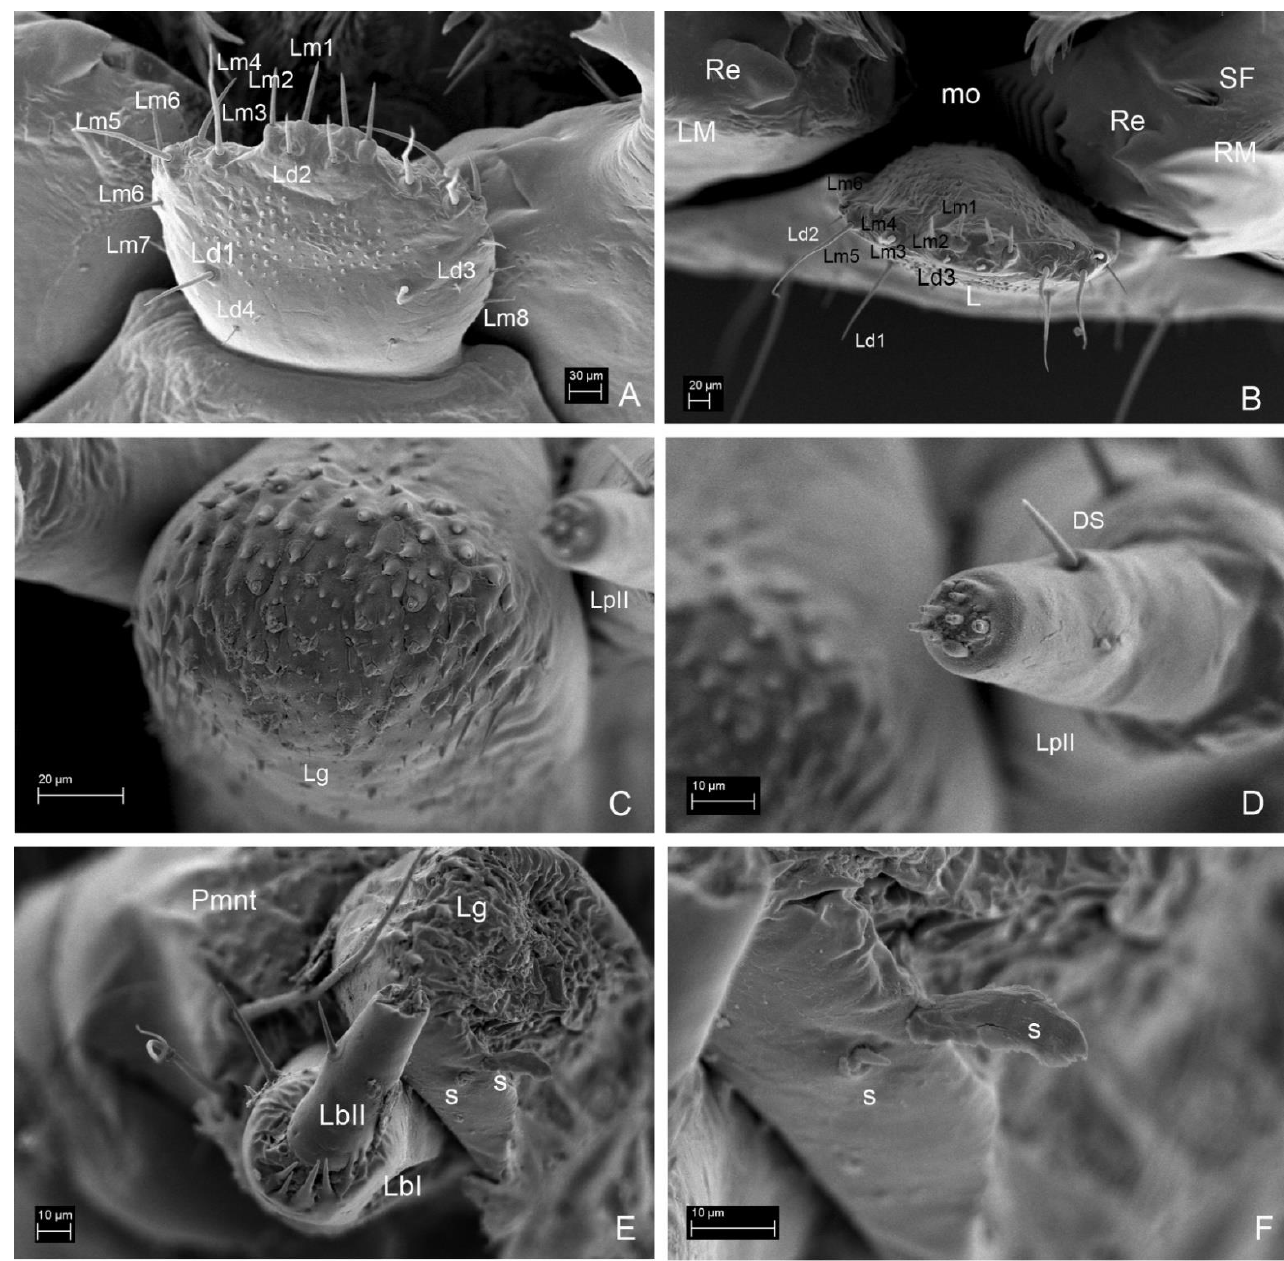
Figure 11. Leiodes cinnamomea . Details of larval morphology of instar III. Mouthparts. ( A ) labrum, dorsal side. ( B ) Labrum, apical view. ( C ) Labium—ligula, apical view. ( D ) Labial palp II. ( E ) Labial palpi and ligula. ( F ) Sensilla of ligula. Abbreviations: DS—digitiform sensillum of maxillary palp; LpI, LpII—labial palpi segment I, II; Lg—ligula; LM—left mandible; mo—mola; Mnt—mentum; Pmnt—prementum, Re—retinaculum; RM—right mandible; SF—setal field. The other abbreviations refer to the terminology of setae.